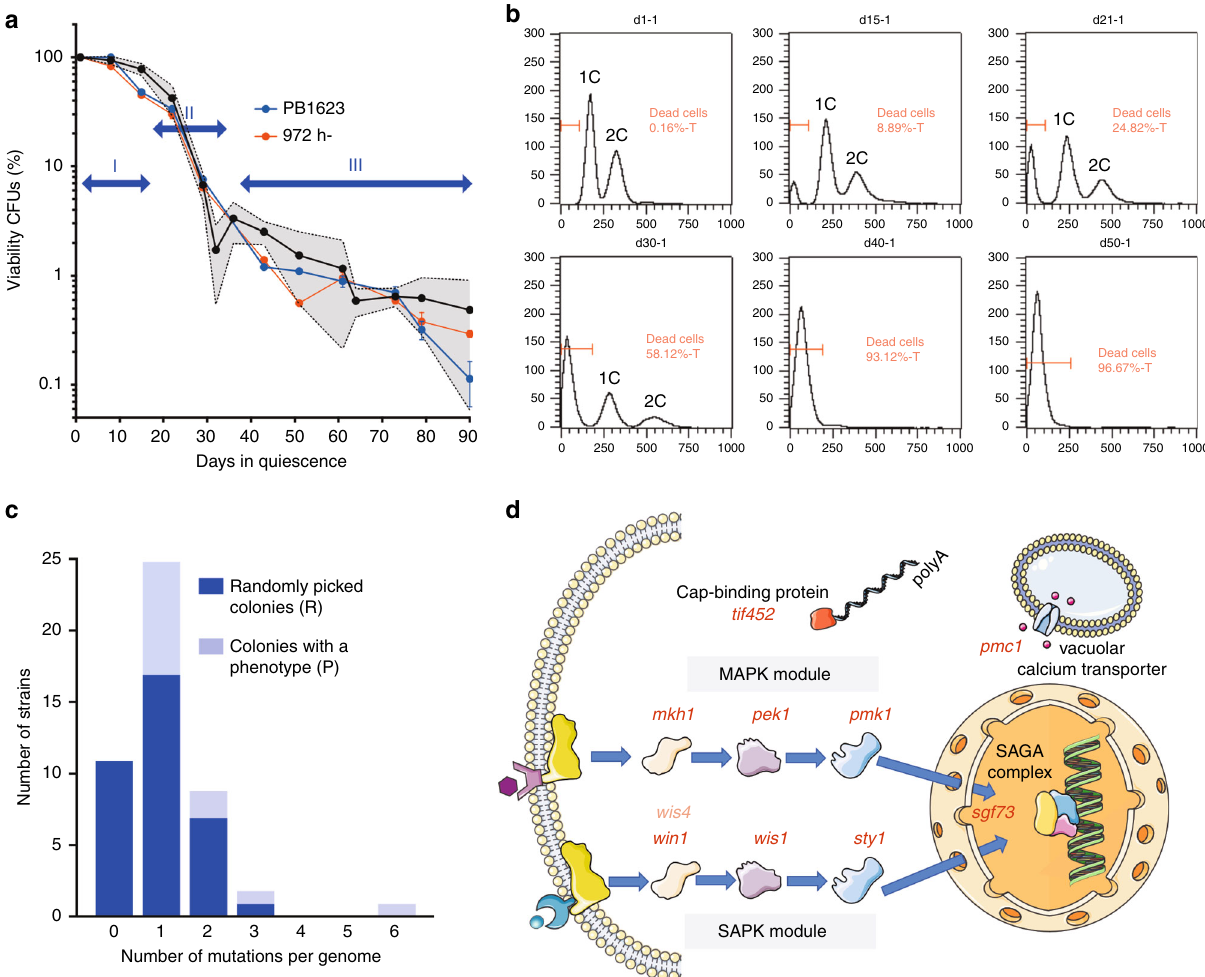
Fig. 1 Viability and distribution of mutations in nitrogen-starved cultures. a The ability to form colonies (CFUs) was monitored on 17 independent cultures for 3 months by plating aliquots of the cultures on rich medium at various time points (black curve). The mean is represented and the gray area delineates the limits of the standard deviations. The red (wild-type reference strain 972 h - ) and blue (our wild-type progenitor PB1623) curves were made in parallel on a culture that was split into three on day 1 of quiescence. The CFUs were determined in triplicate at days 21, 61, 73, 79, and 90. The three phases are highlighted. Source data are provided as a Source Data fi le. b Analysis of the DNA content of PB1623 cells determined by FACS at 1, 15, 21, 30, 40, and 50 days of starvation. c Distribution of the number of mutations per genome after 3 months of starvation in the 36 randomly picked (R) colonies and in the 12 colonies selected for their sensitivity to various agents. d Schematic representation of the pathways in which the nine genes analyzed in